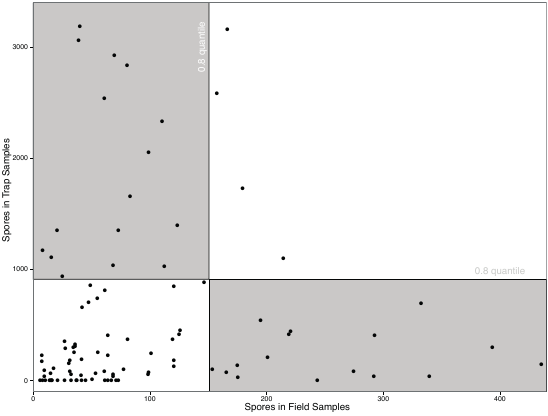
Figure 2 – Dispersion plot of AMF spore counts for samples from fi eld and traps. Black lines indicate the 0.8 percentile for each method. Points occurring in the grey shaded areas correspond to samples with spore counts above the 0.8 percentile for each